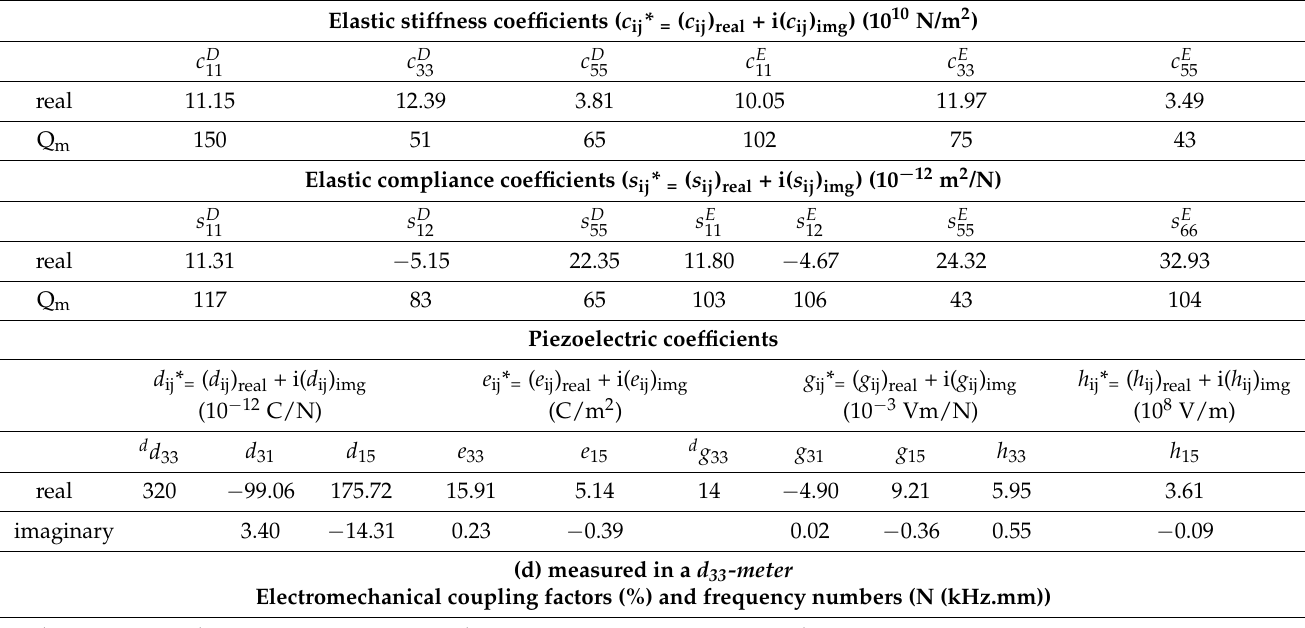
Table 1. Piezoelectric, dielectric, and elastic complex coefficients at resonance of BCZT8-5 ceramics ( ρ = 5.65 g/cm 3 ) from resonances of thickness-poled thin disks and plates measured at 25 ◦ C. Electromechanical coupling factors and frequency numbers are also